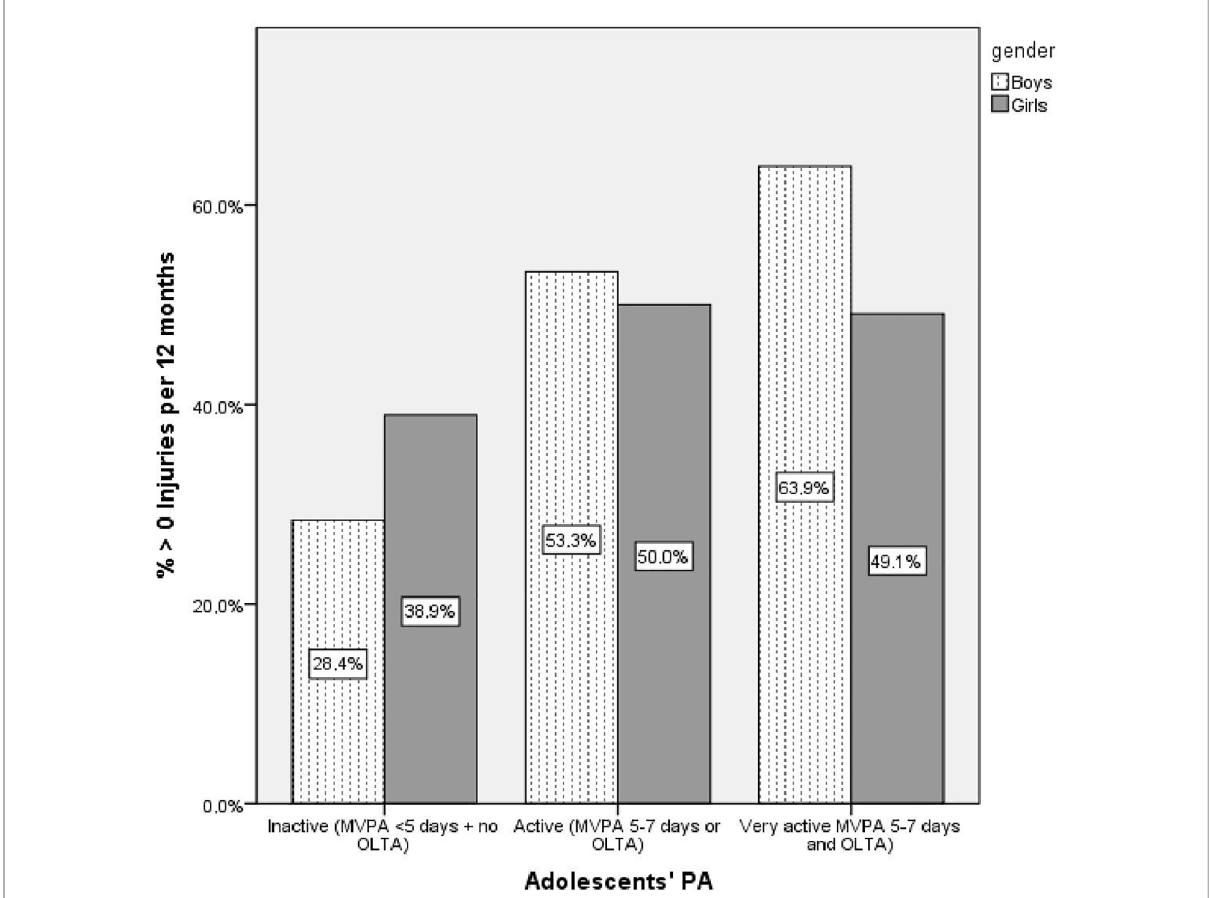
FIGURE 1 Moderation by gender of the association of medically attended injuries with adolescents ’ physical activity. MVPA, moderate-to-vigorous physical activity; OLTA, organised leisure-time